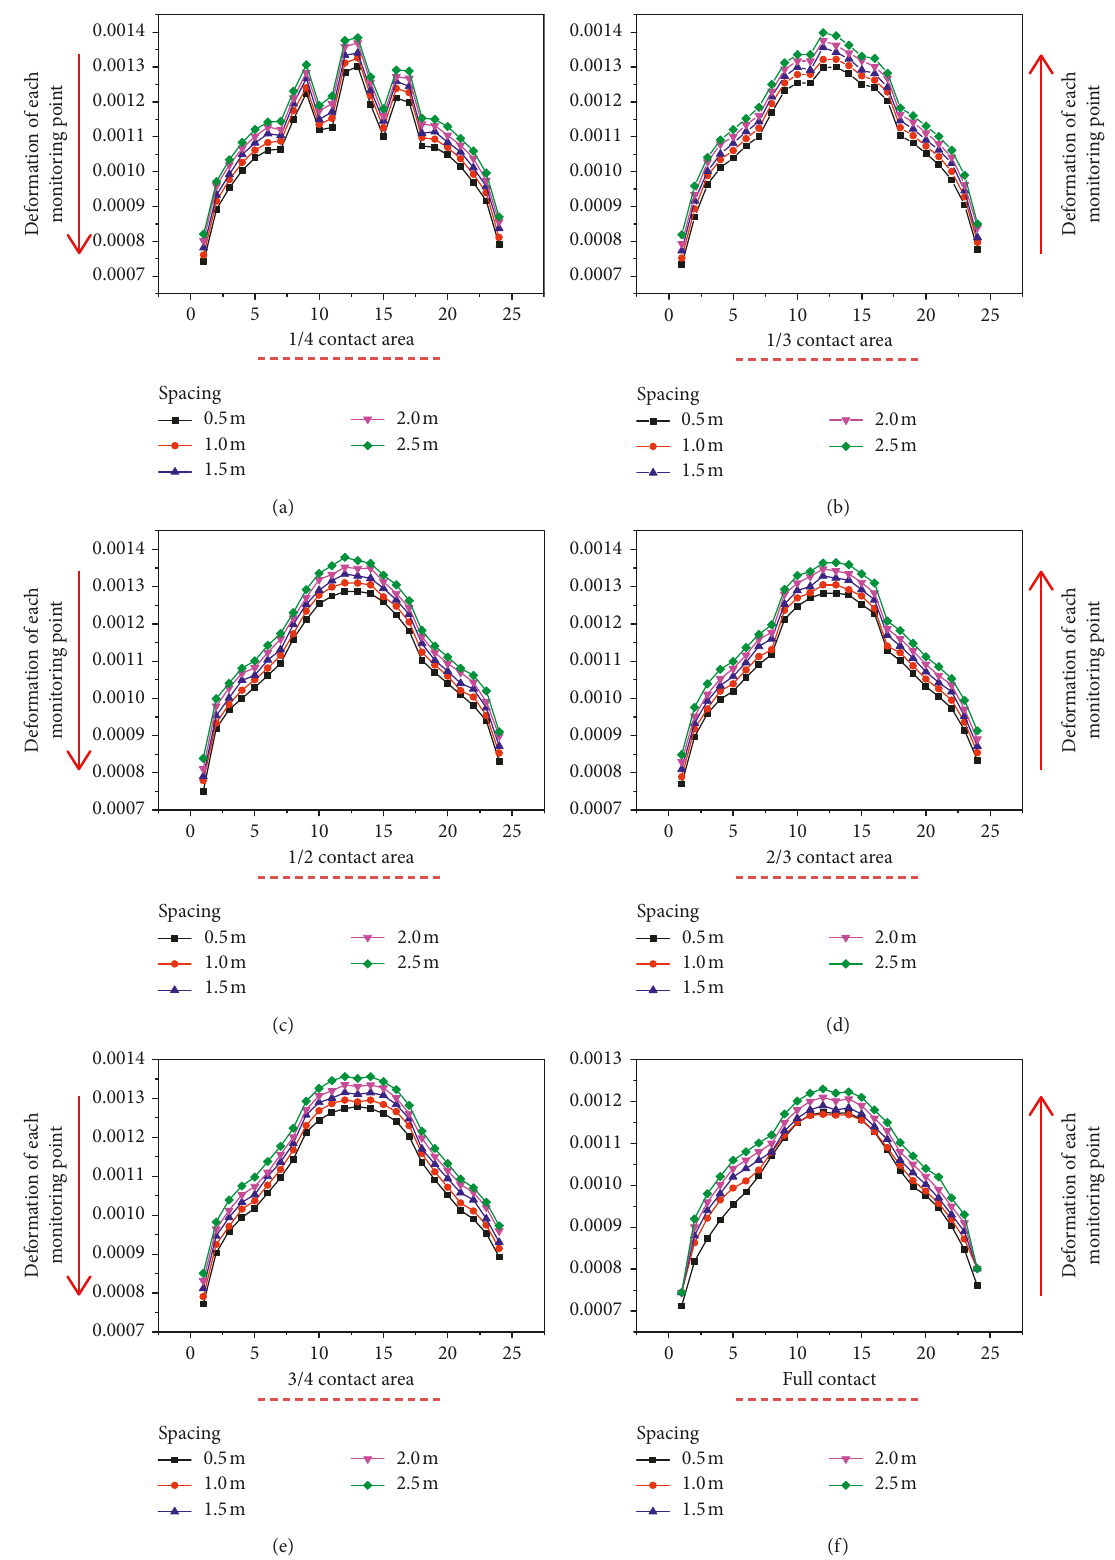
Figure 10: Various factors and contact area ratio for the deformation: (a) 1/4; (b) 1/3; (c) 1/2; (d) 2/3; (e) 3/4; (f) 1/1. The black curve represents the distance of 0.5m; the red curve, the distance of 1.0m; the blue curve, the distance of 1.5m; the pink curve, the distance of 2.0m; the green curve, the distance of